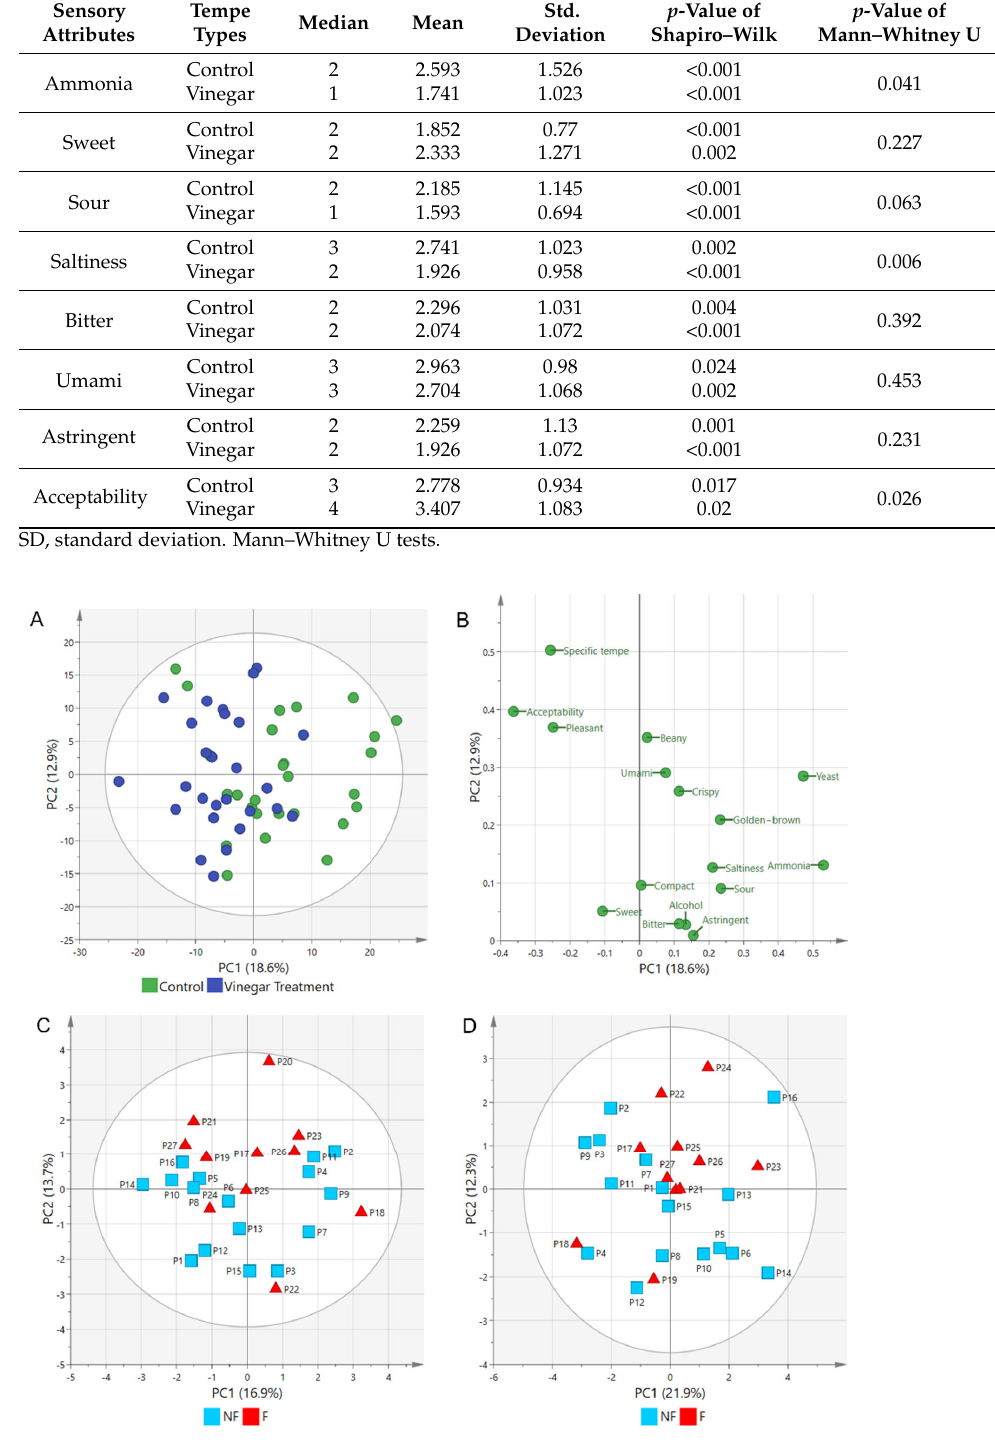
Figure 3. Principal component analysis (PCA) of rate-all-that-apply (RATA) tests of two types of tempe and panelist performance. ( A ) Score plot. ( B ) Loading plot. Panelist performance was based on familiarity with tempe sensory characteristics before RATA tests. Score plots of panelist performance for tempe fermented without (control) ( C ) and with ( D ) vinegar.